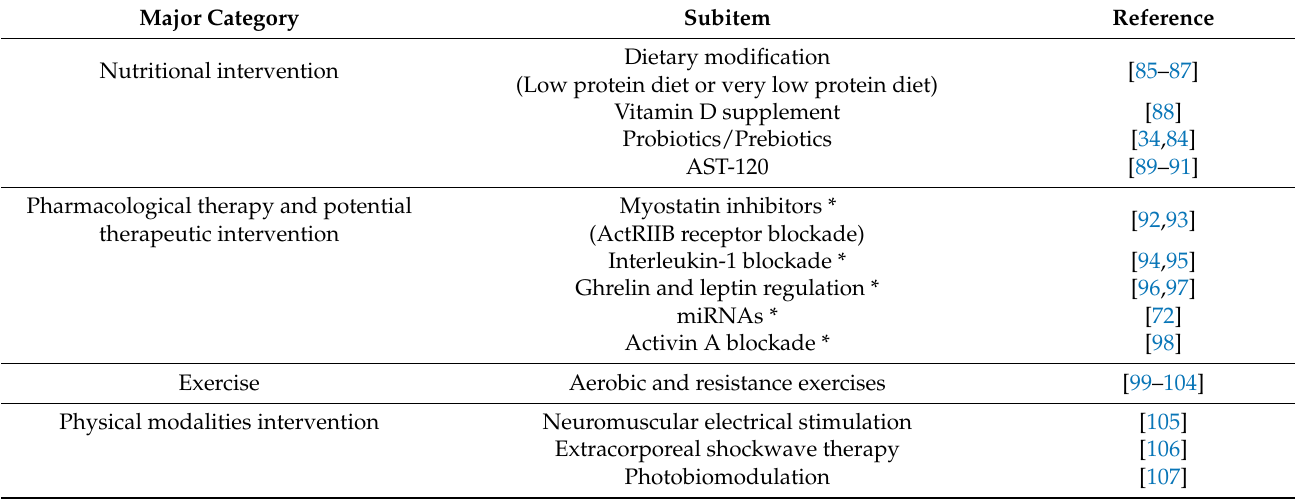
Table 1. Standard care and potential intervention against muscle wasting in patients with